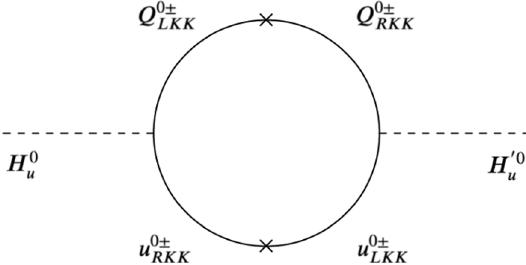
Figure 6 . Loop diagram generating isoneutral Higgs doublet mass mixing. A similar diagram for down type Higgs doublets is obtained by changing u → d